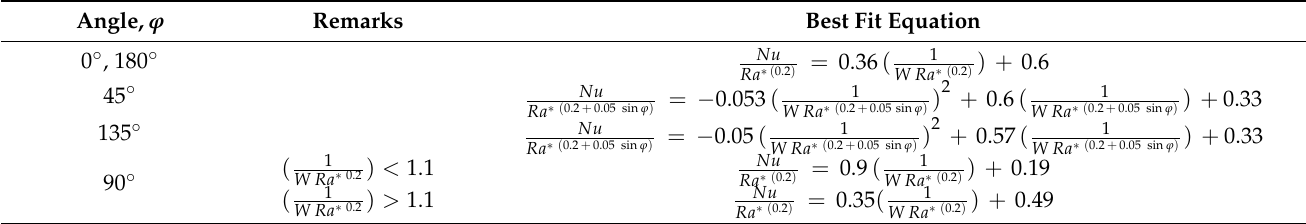
Table 4. Forms and values of constants used in Equation